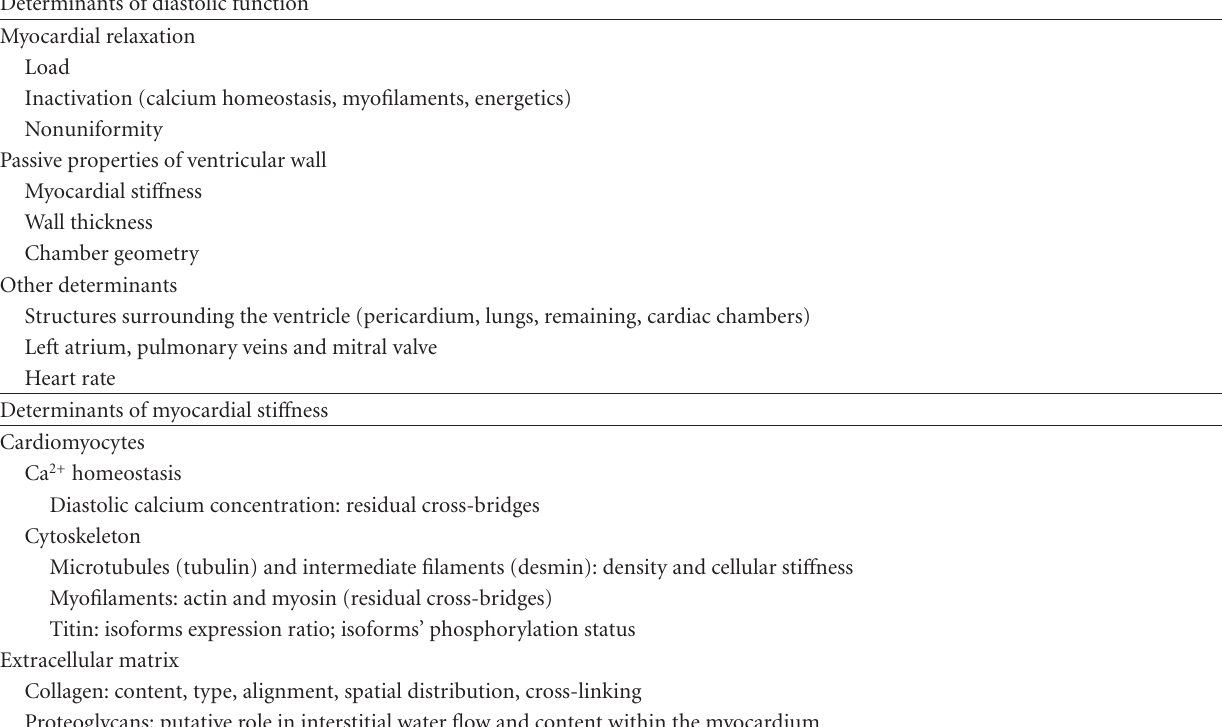
Table 1: Determinants of diastolic function and myocardial sti ff